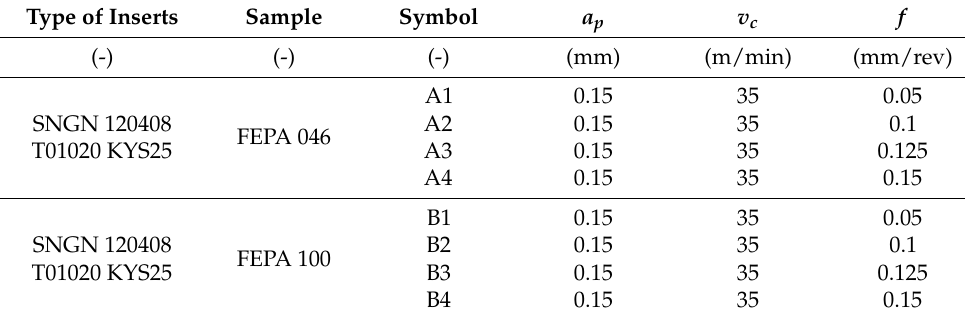
Table 2. Technological parameters of the cutting process used for tests.